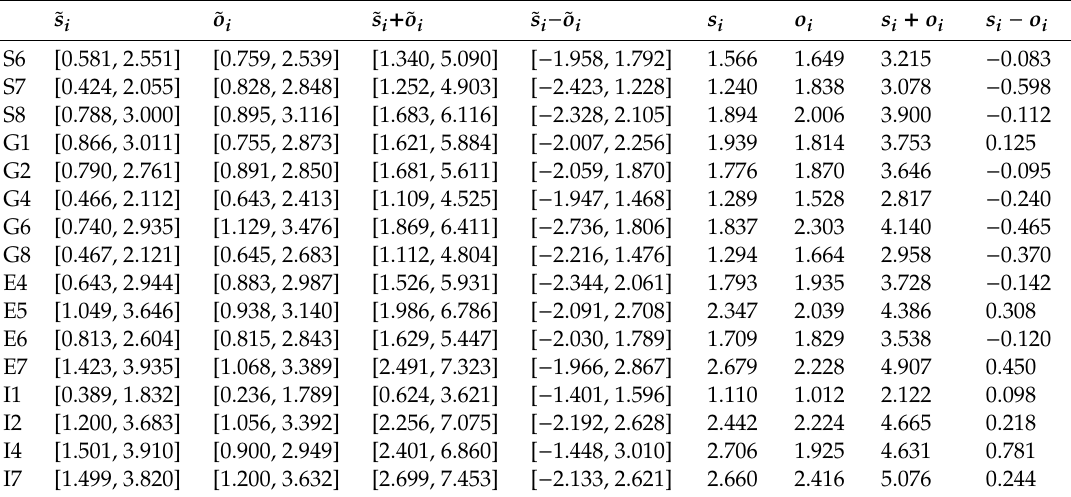
Table 6. Sum of the defuzzification of rough influences given and received by